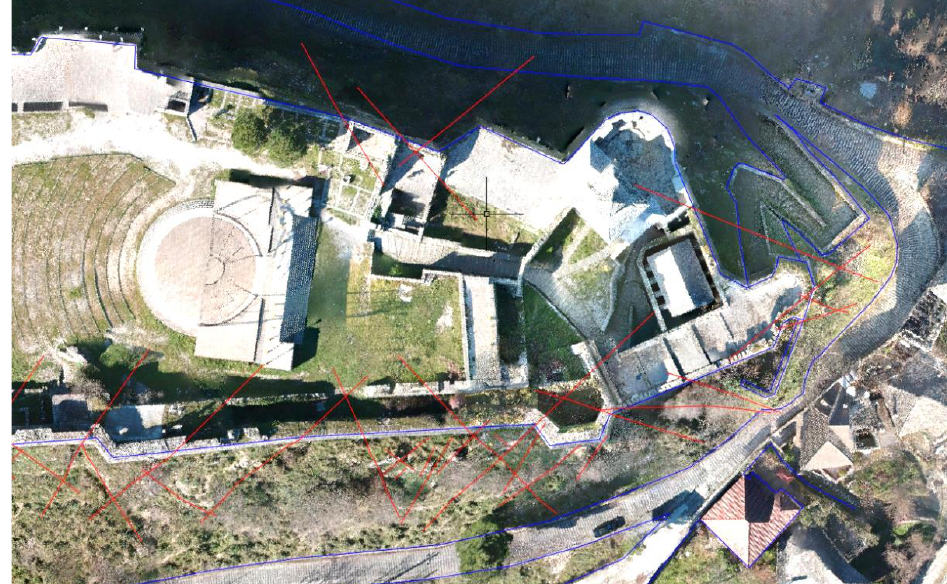
Figure 4. Detailed image of main joints in the conglomeratic around the tower located at the north- eastern end of the fortress (in red). Blue lines mark the outline of the fortress and the roads below. (Photo credit: GEA, based on photo by Rand Eppich).